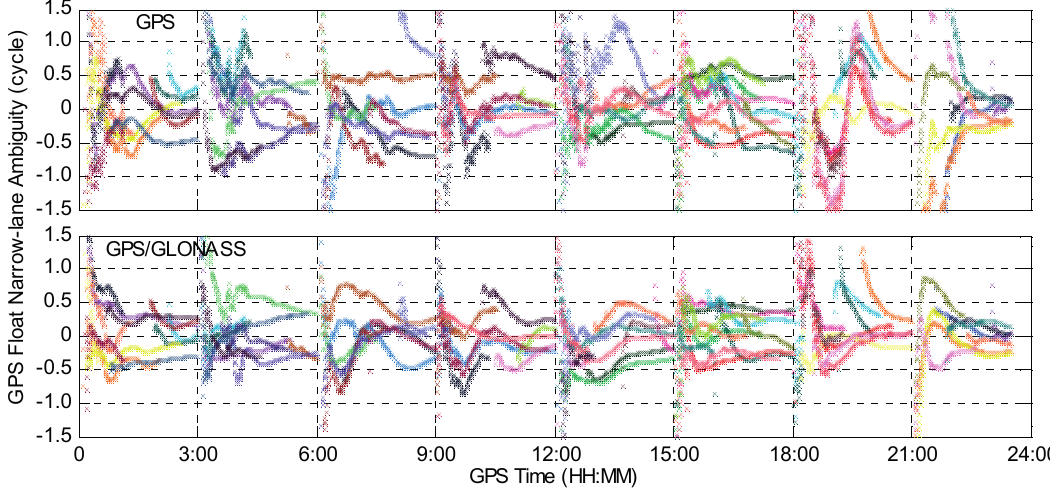
Figure 5. GPS narrow-lane ambiguity-float values for GPS-only and combined GPS/GLONASS precise point positioning at IGS station BJFS on 1 February